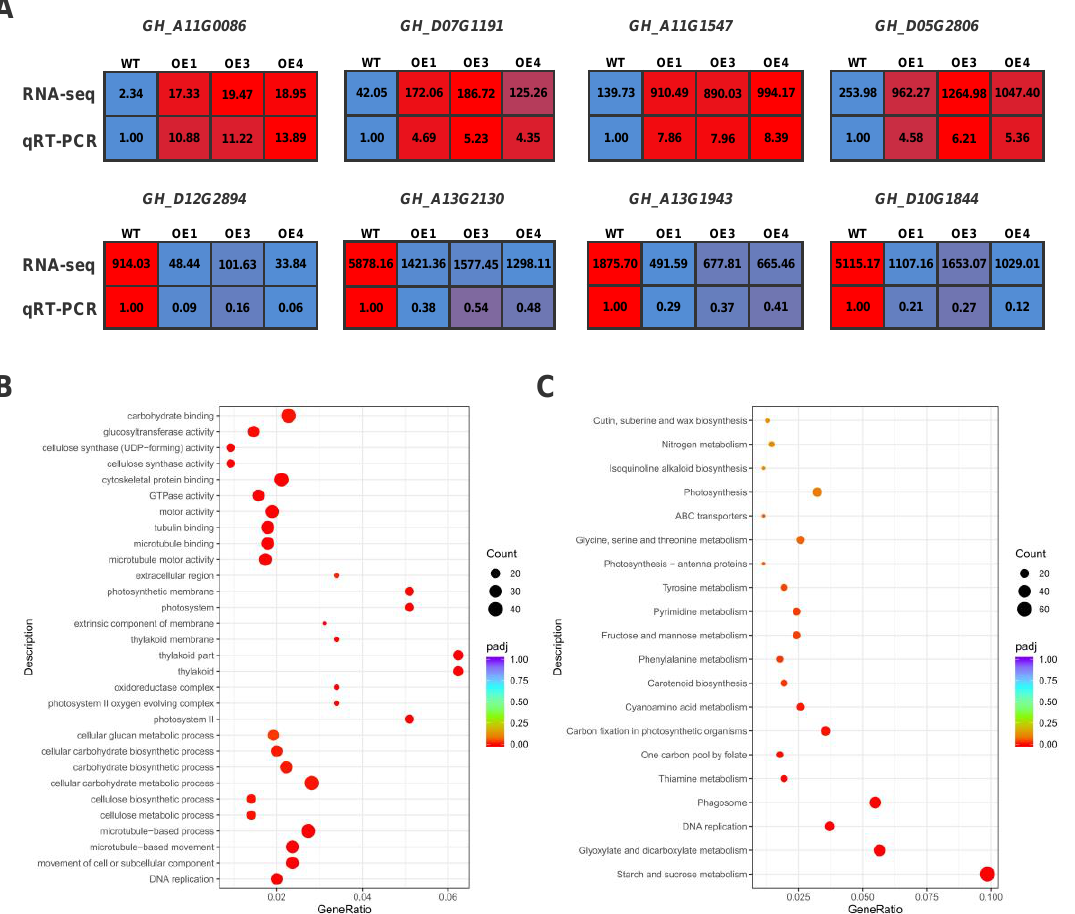
Figure 6. RNA-Seq analysis of OE1, OE3, and OE4 after drought treatment. ( A ) qRT-PCR validation of four up- and four down-regulated genes measured by RNA-seq. Values represent the mean ± S.D. ( n = 3 replicates). ( B ) Drought treatment significantly changes enriched KEGG terms. ( C ) GO